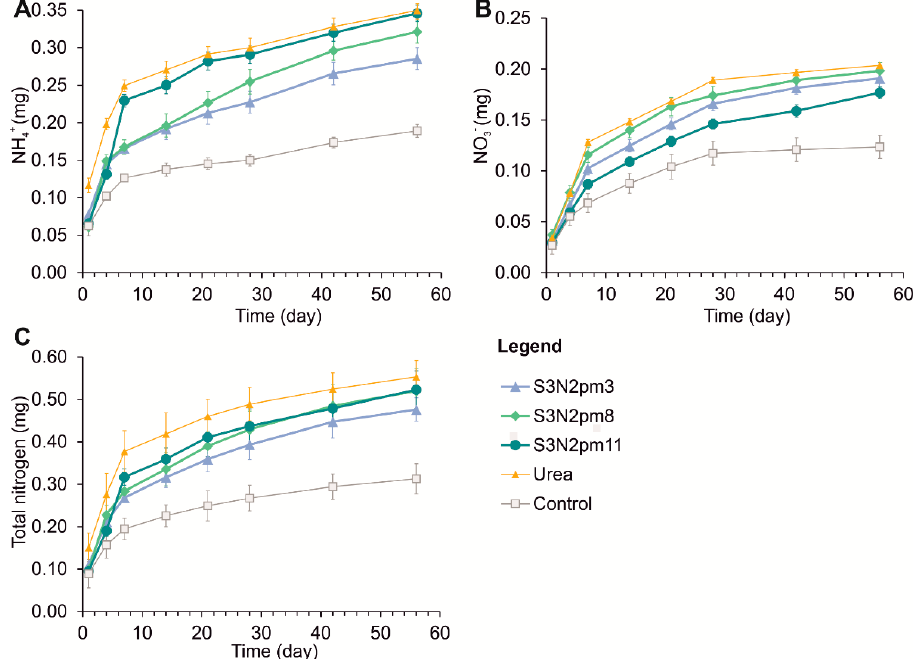
Figure 6. Cumulative release of ( A ) NH 4+ , ( B ) NO 3 − , and ( C ) total nitrogen during the soil leaching test. Note the sharp decrease in the steepness of curves after 6 to 7 days. The statistical significance of every parameter indicates at the p = 0.05 level. Bars represent standard deviation.